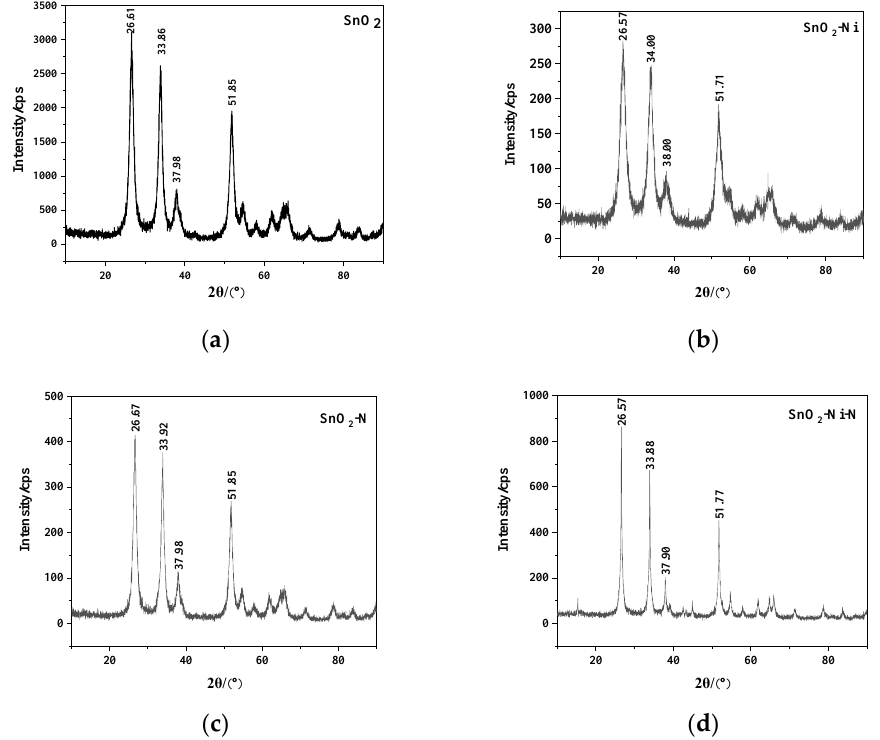
Figure 5. XRD patterns: ( a ). SnO 2 ; ( b ). SnO 2 – Ni; ( c ). SnO 2 – N; ( d ). SnO 2 – Ni – N.